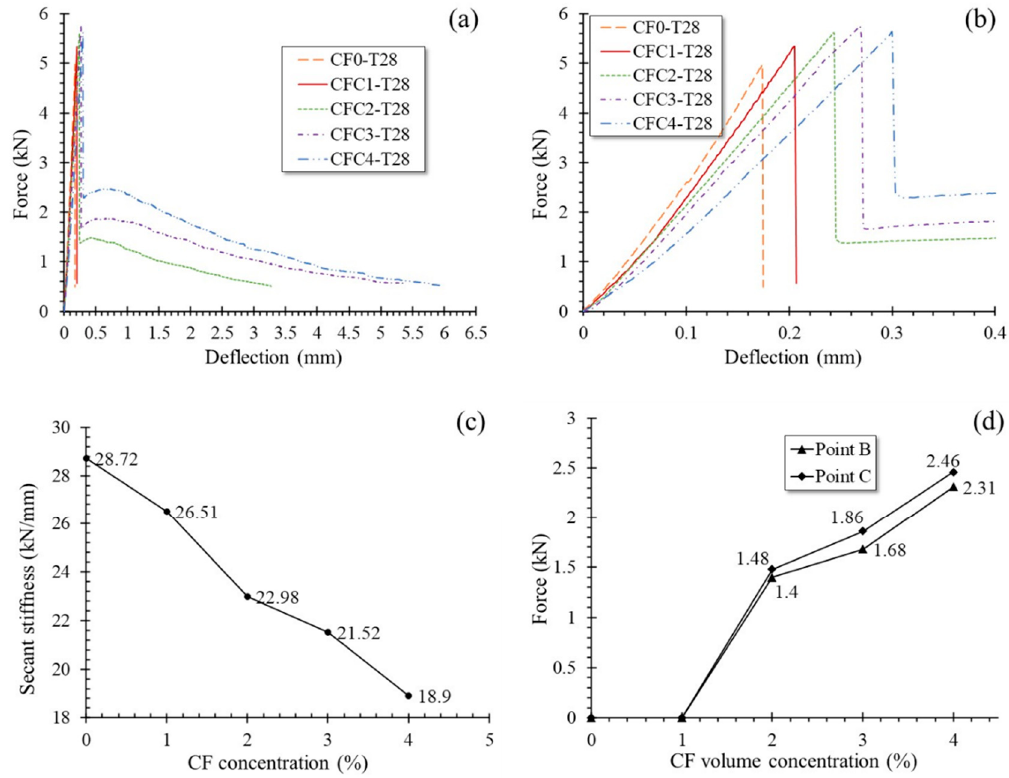
Figure 12. Load-deflection (L-D) curves and secant stiffness of group T28: ( a ) L-D curves; ( b ) Enlarged view in O–A; ( c ) Secant stiffness of O–A; ( d ) Loading force at point B and C.